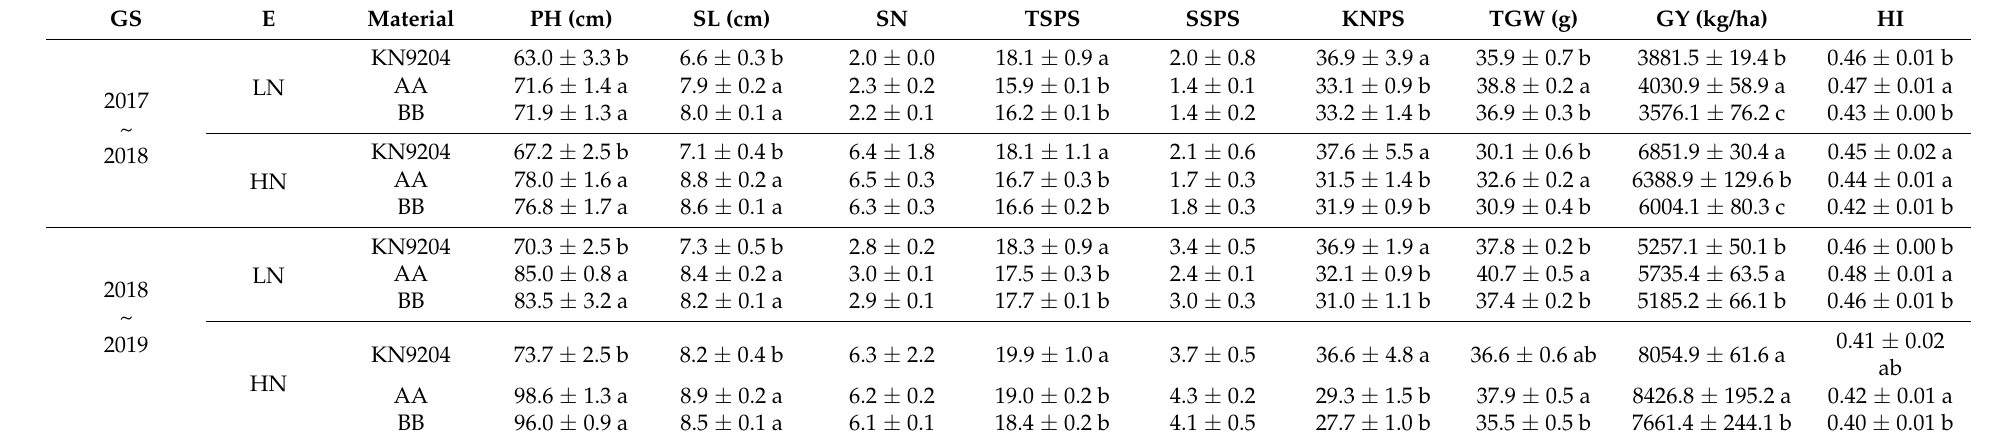
Table 3. Agronomic traits of KN9204 and the QMrl - 7B